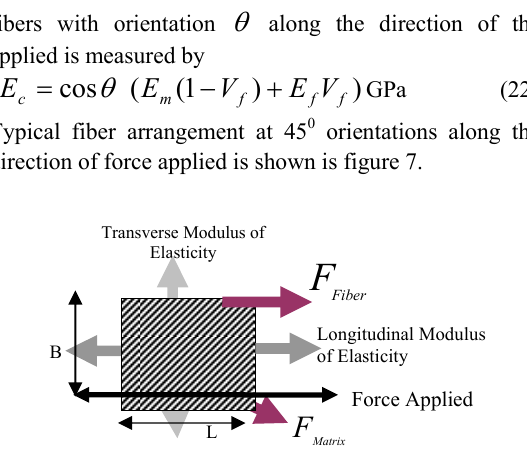
Figure 7: Composite structure having aligned fibers with orientation at 45 0 along the direction of the force applied. The modulus of elasticity of continuous and oriented fiber composite loaded in the transverse direction of the force